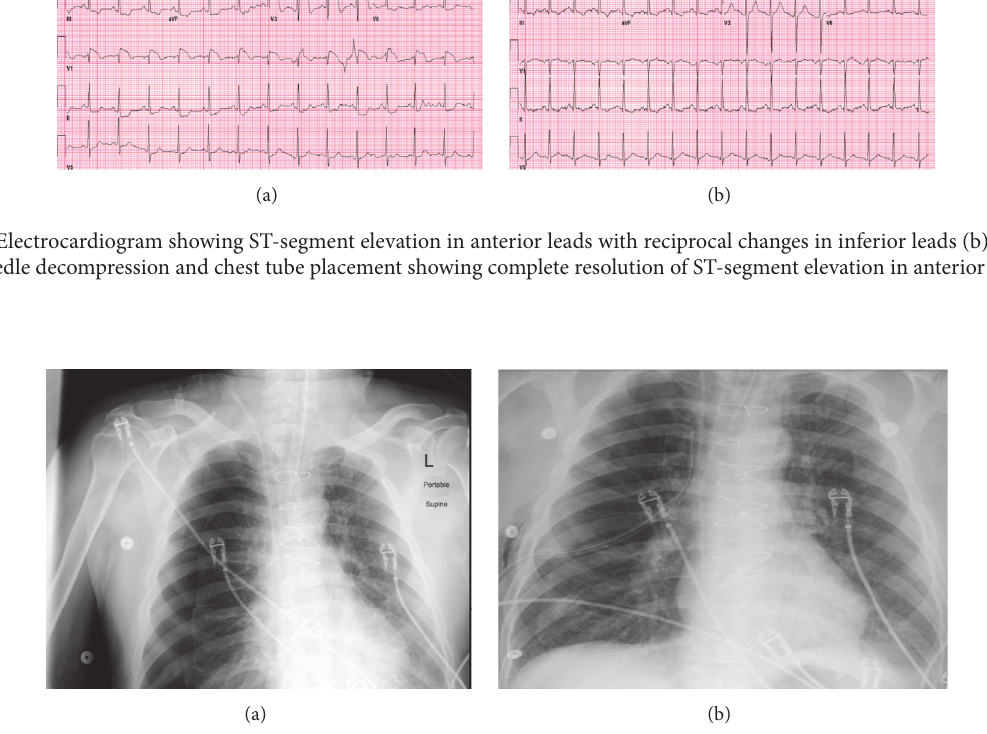
Figure 2: (a) Chest X-Ray showing large right-sided pneumothorax with lung margin collapse more than 4cm from the chest wall uniformly. (b) Chest X-Ray showing Interval placement of chest tube with tip in the right suprahilar area with near-complete lung